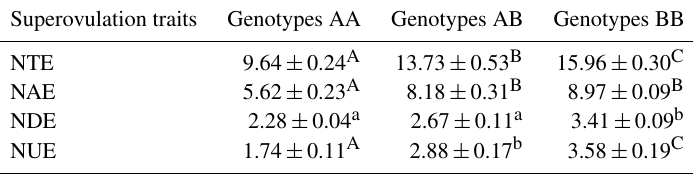
Figure 2. Analysis of the expression of ZNF33B in different periods of bovine ovary and corpus luteum. (a) Relative expression of ZNF33B in bovine ovary. (1) Ovarian cortex during corpus phase; (2) ovarian cortex in the follicular phase; (3) ovarian medulla. (b) Relative expression of ZNF33B in different stages of corpus luteum. (1) Corpus hemorrhagicum; (2) corpus luteum; (3) corpus albicans. ∗ p< 0 . 05, ∗∗ p< 0 . 01, ∗∗∗ p< 0 . 001. Table 2. Statistical table of cattle superovulation with the different